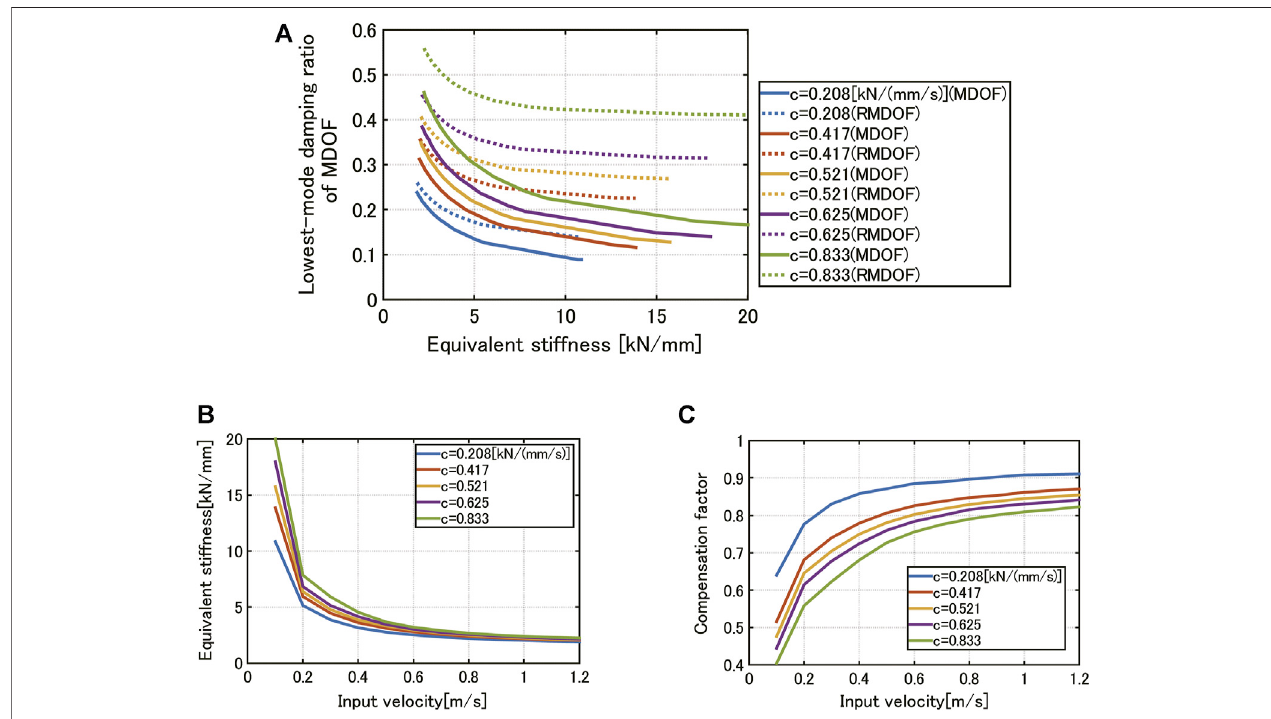
FIGURE 9 | Evaluation of compensation factor, (A) Relation of lowest-mode damping ratio of MDOF model and RMDOF model with equivalent stiffness of base- isolation story where fi ve damping coef fi cients of connecting damper, (B) Relation of equivalent stiffness of base-isolation story with input velocity level, (C) Relation of compensation factor with input velocity